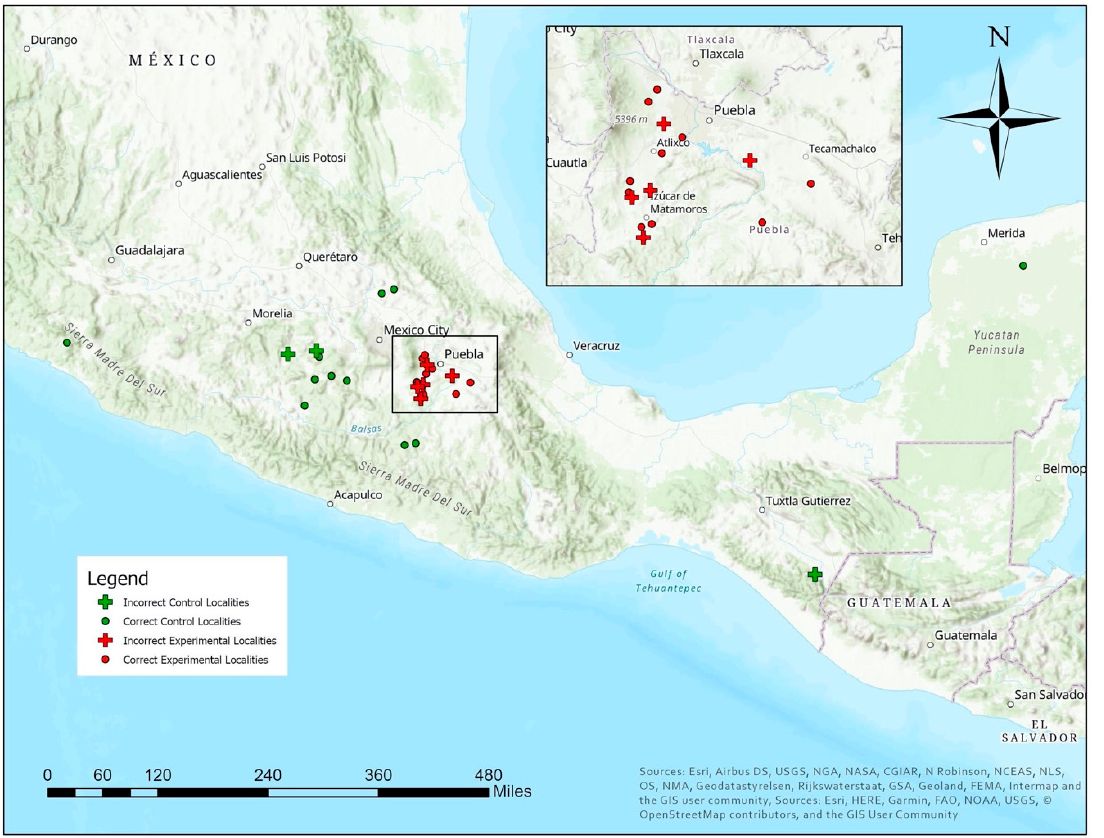
Figure 9. Map of the 15 control and 15 experimental localities. The plus symbol indicates incorrect control or experimental localities.